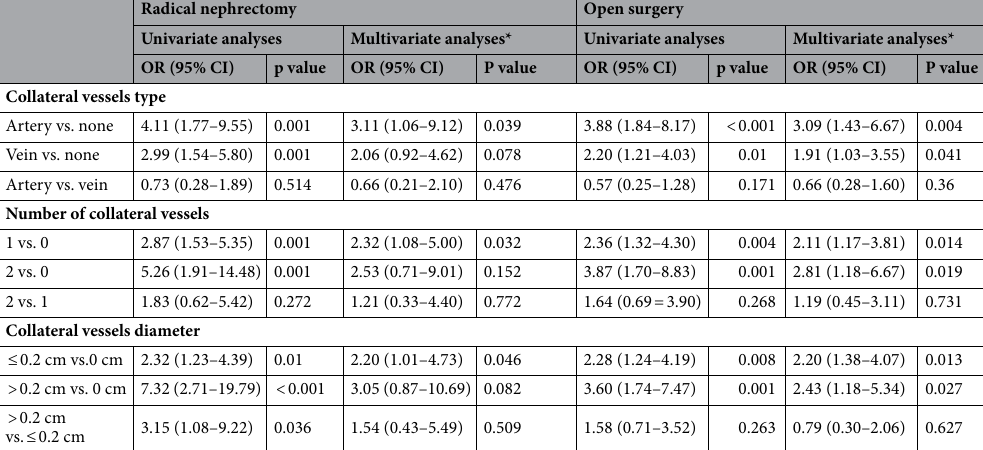
Table 7. Univariate and multivariate analyses of different subgroups of collateral vessels in predicting radical nephrectomy and open surgery. *The multivariate analyses were conducted including parameters with p value < 0.05 in univariate analyses in Table